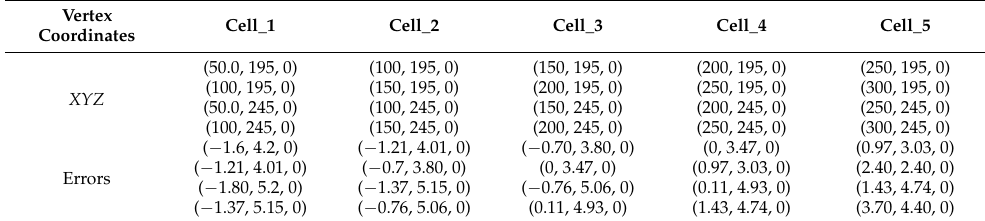
Table 2. Coordinates and errors of cell vertex on horizontal channel.